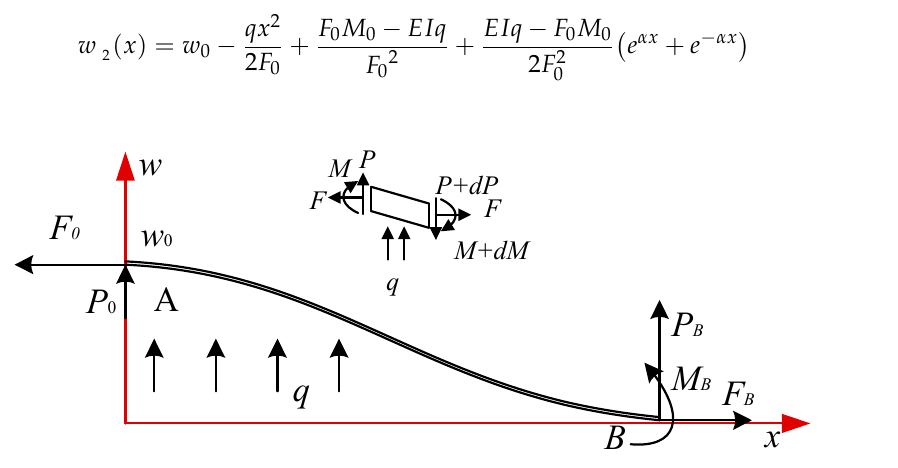
Figure 4. Mechanical model for pipe segment (AB) in liquefaction zone.